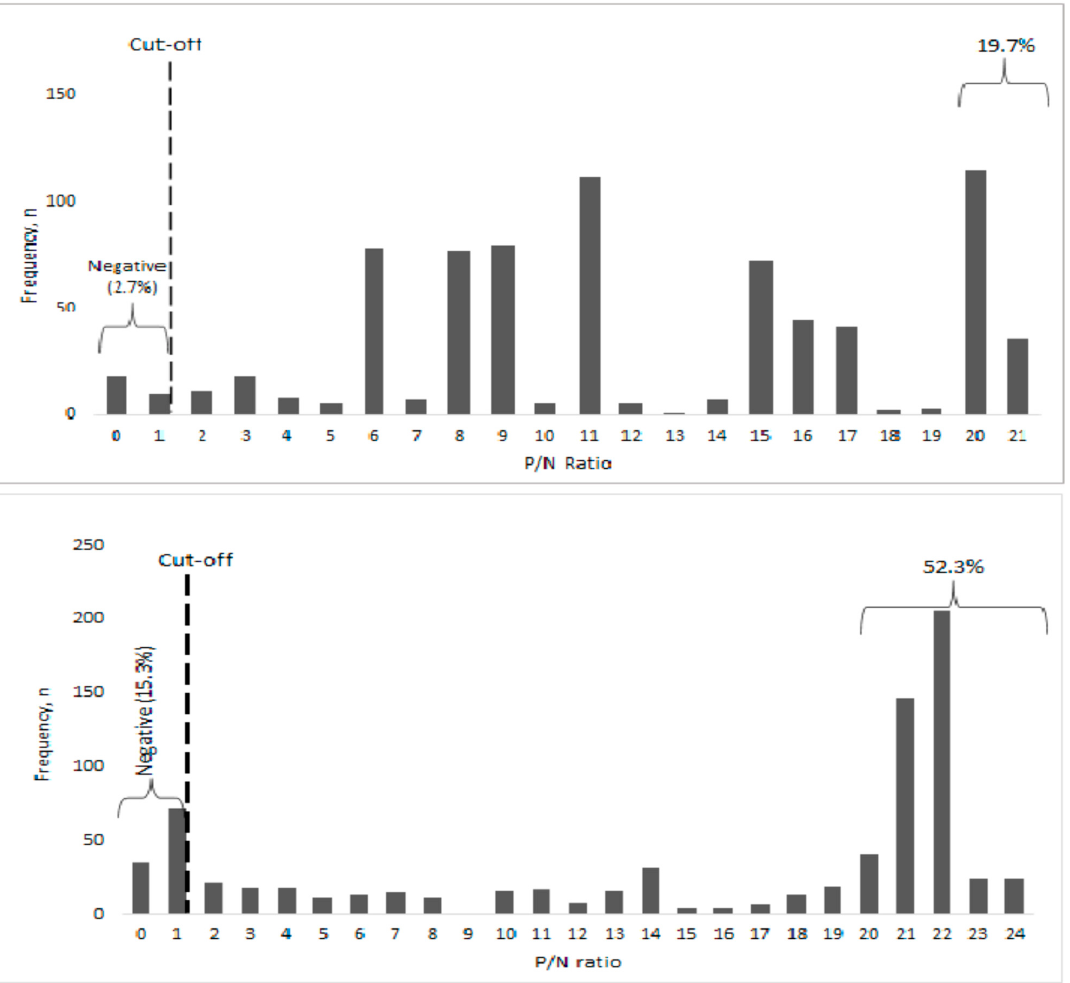
Figure 2. Frequency of the P/N ratio among urban (top panel) and rural (bottom panel) participants in Kenya, February 2022. Results were expressed as positive/negative ratios, with a value ≥ 1 con- sidered positive. A significantly higher proportion of rural participants were more immunoreactive, suggesting recent infection or vaccination.